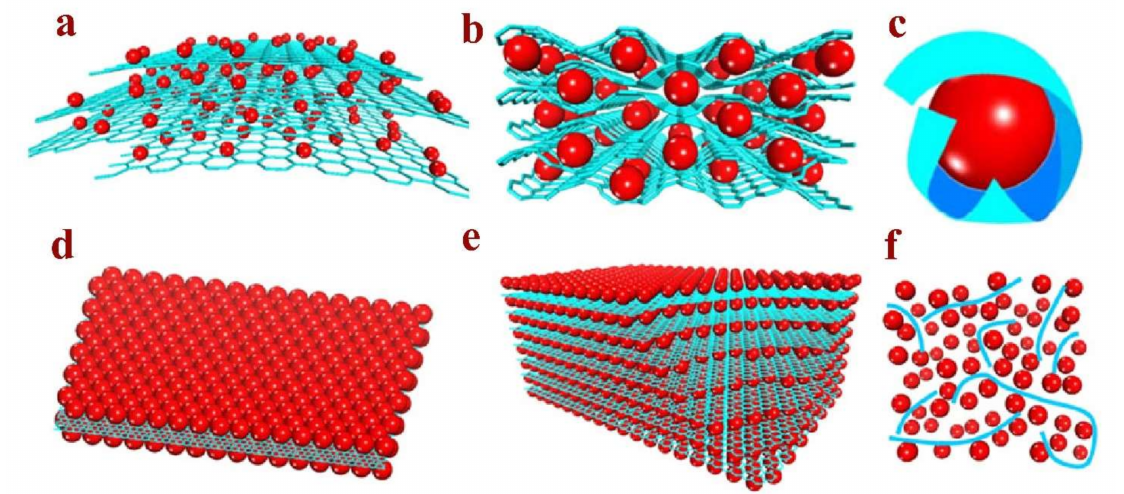
Figure 13. Schematic representation of metal oxide/graphene composite models: ( a ) surface anchored model, ( b ) wrapped model, ( c ) encapsulated model, ( d ) sandwich model, ( e ) layered model, and ( f ) mixed model. In the structures, red balls represent metal oxide particles and the blue sheets represent 2D graphene sheets. Adapted and reproduced with permission from Ref. [20]. Copyright 2012